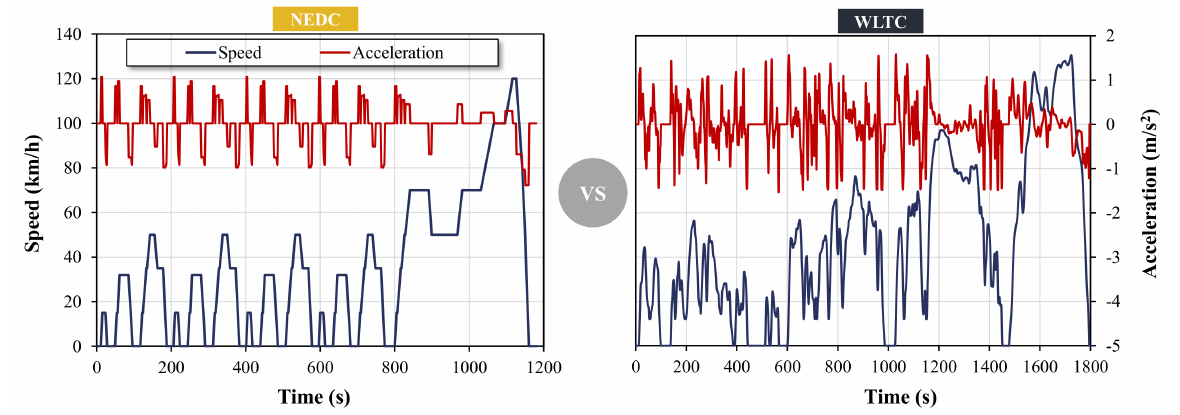
Figure 3. Comparisons of the NEDC and WLTC driving cycles